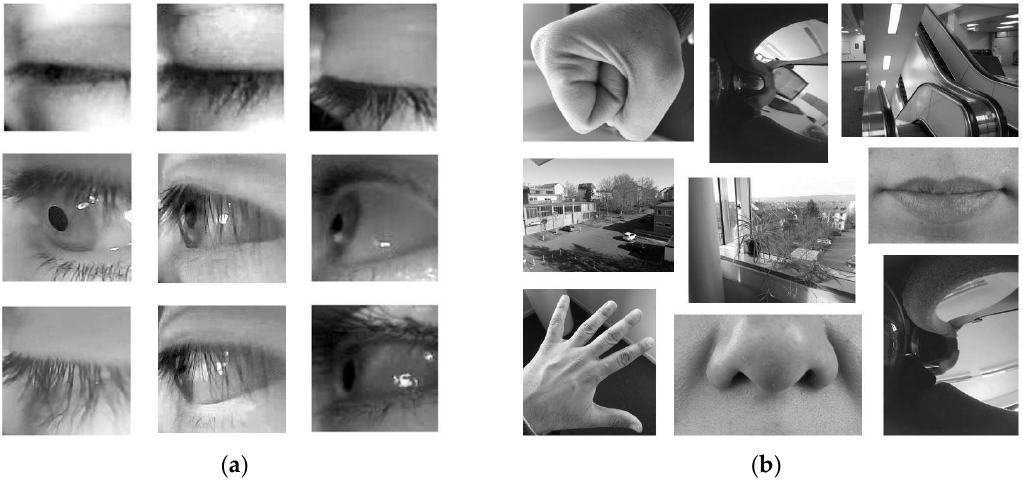
Figure 8. Sample images used to train the Haar cascade classifier (HCC): ( a ) Example of positive samples; ( b ) Example of negative samples.